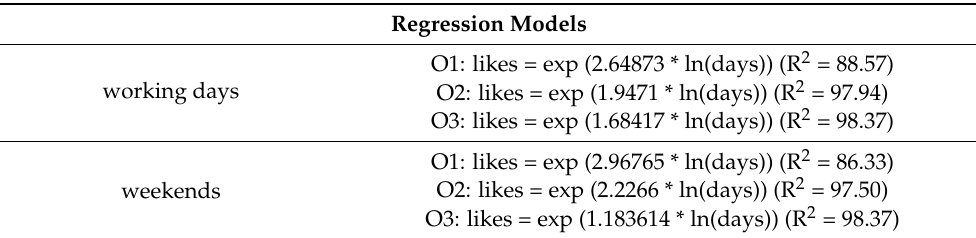
Table 4. Linear regression model for likes during working days and weekends in each